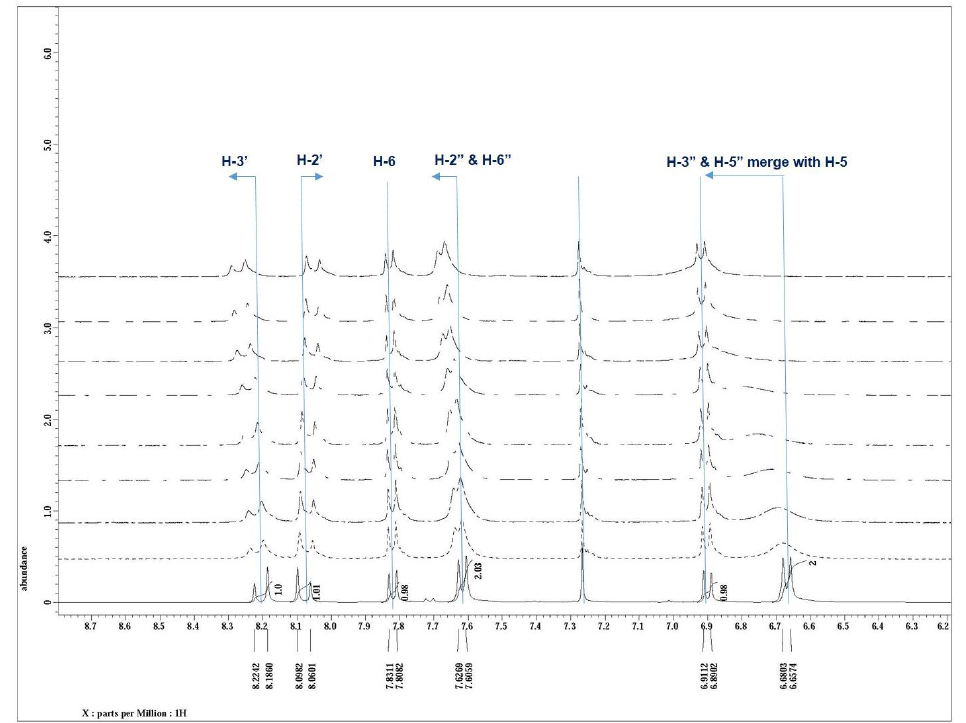
Figure 7. 1 H-NMR spectra of compound 8 in CDCl 3 showed shifts in aromatic protons on the addition of DCP (0–4 eq.).